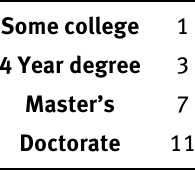
Table 2: Education completed by participants.